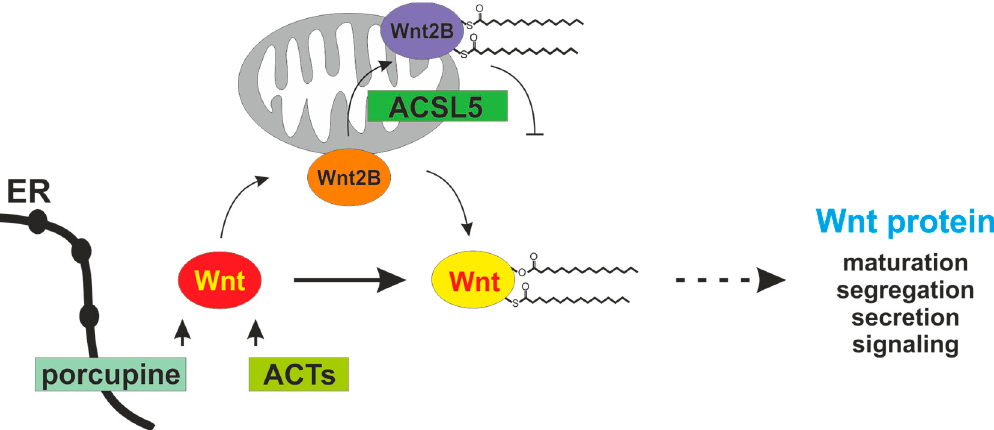
Figure 2. Scheme of Wnt lipidation and modifiers. The endoplasmic reticulum (ER)-associated acyltransferase porcupine is essential for Wnt lipidation with palmitoleic acid at S209 or equivalents and probably contributes to C77 palmitoylation. Porcupine is probably assisted by other acyl-CoA transferases (ACTs). Mitochondrial Wnt2B is arrested by ACSL5-dependent palmitoylation and does not further contribute to nuclear Wnt signaling.